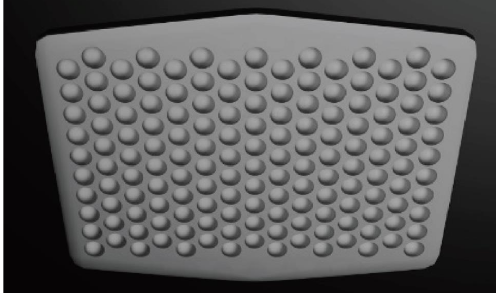
Figure 4: Spherical concavities design.